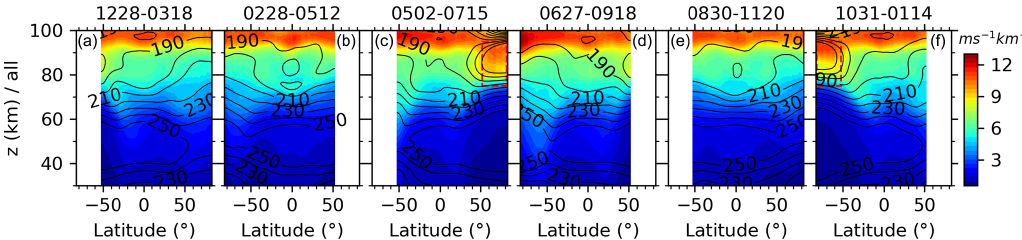
Figure 15. Same as Fig. 7 but for the zonal means of GW-perturbed shears derived under the medium-frequency assumption f/ ˆ ω j = 0.